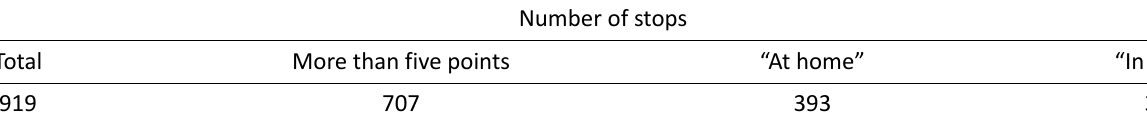
Table 1. Respondents’ stops during weeks 8, 9, and 17 of 2017.